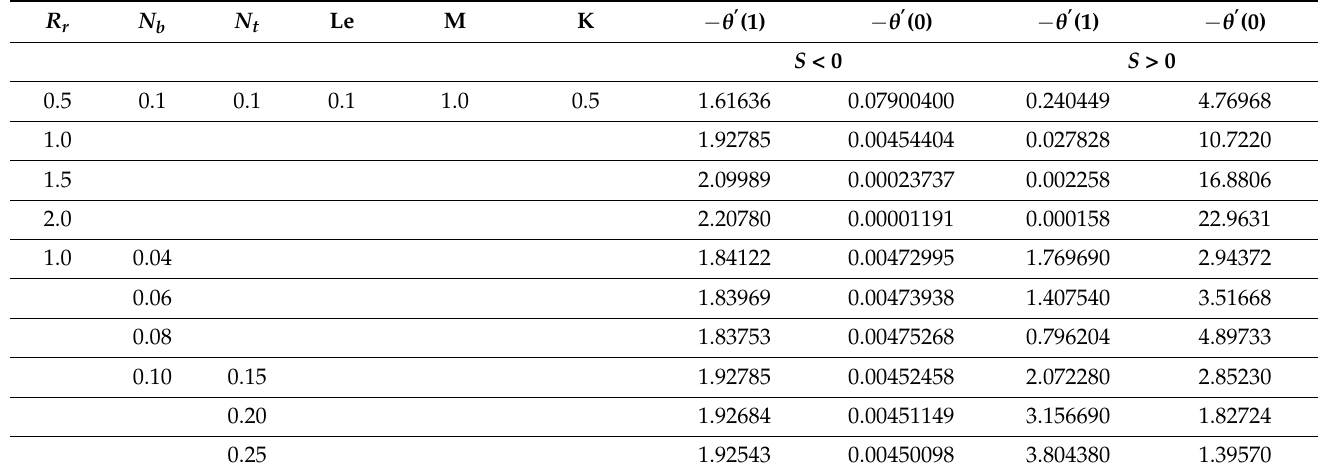
Table 9. Local Nusselt number for γ Al 2 O 3 − C 2 H 6 O 2 at lower and upper plane with weak interaction n = 0.5.